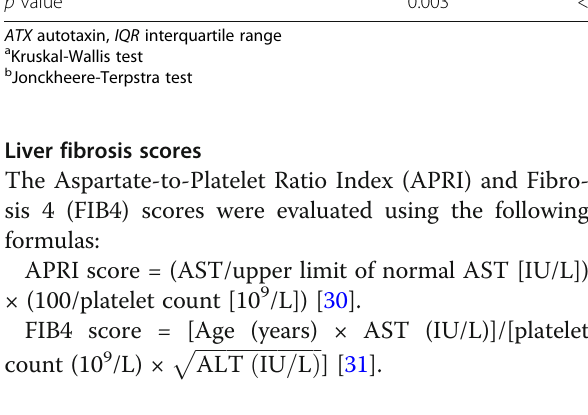
Table 3 Serum ATX levels according to the fibrosis grade at baseline and SVR12 F0 – 1 F2 F3 F4 p value Serum ATX level (pg/mL), median (IQR)